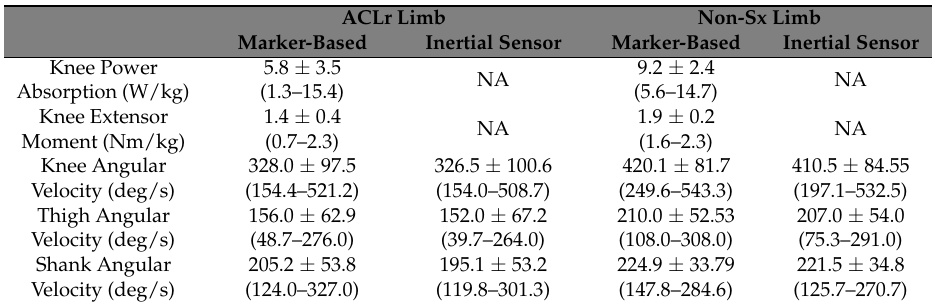
Table 1. Descriptive statistics for the reconstructed (ACLr) and nonsurgical (Non-Sx) limb for joint and segment variables measured with marker-based motion capture and inertial sensor measurement systems; Data represents mean ± standard deviation and (range).